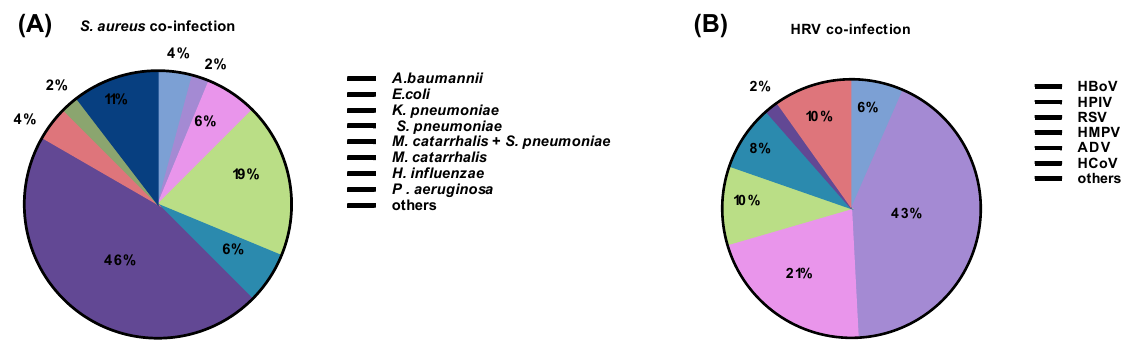
Figure 2: Co-infection of common pathogens (A) distribution of S. aureus co-infection (B) distribution of HRV co-infection.